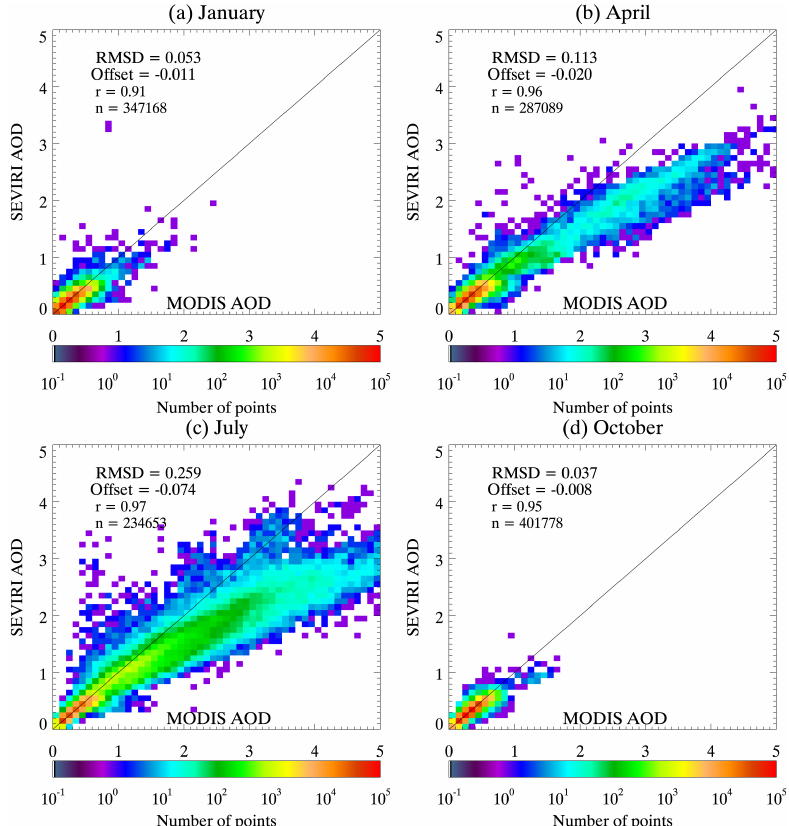
Figure 8. Density plots of MODIS AOD against SEVIRI AOD over the Red Sea